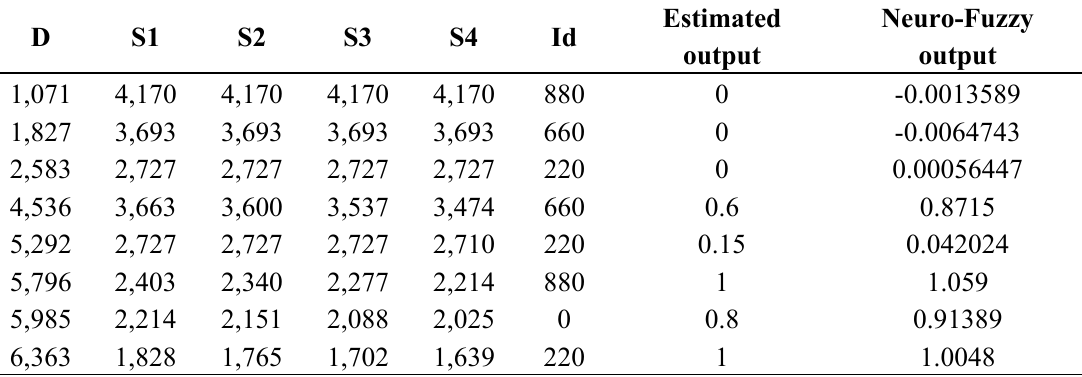
Table 2. Outputs of the Neuro-Fuzzy system for test patterns in the case, where a wall is being detected. S1, S2, S3, S4, Id and D are given in millimeters.